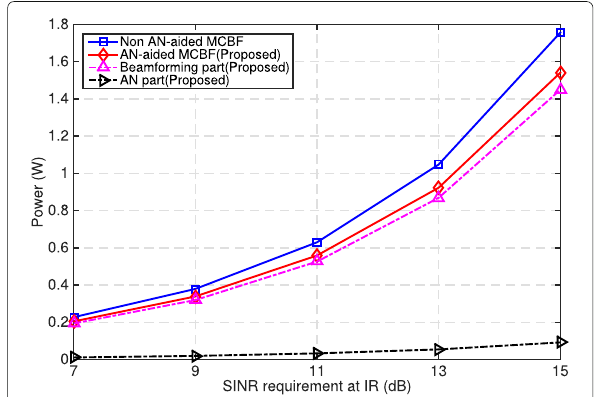
ρ is set as 1 and 0.5, respectively. It is observed that for the linear EH model, the total required power increases lin- early as each ER’s required output DC power θ increases.